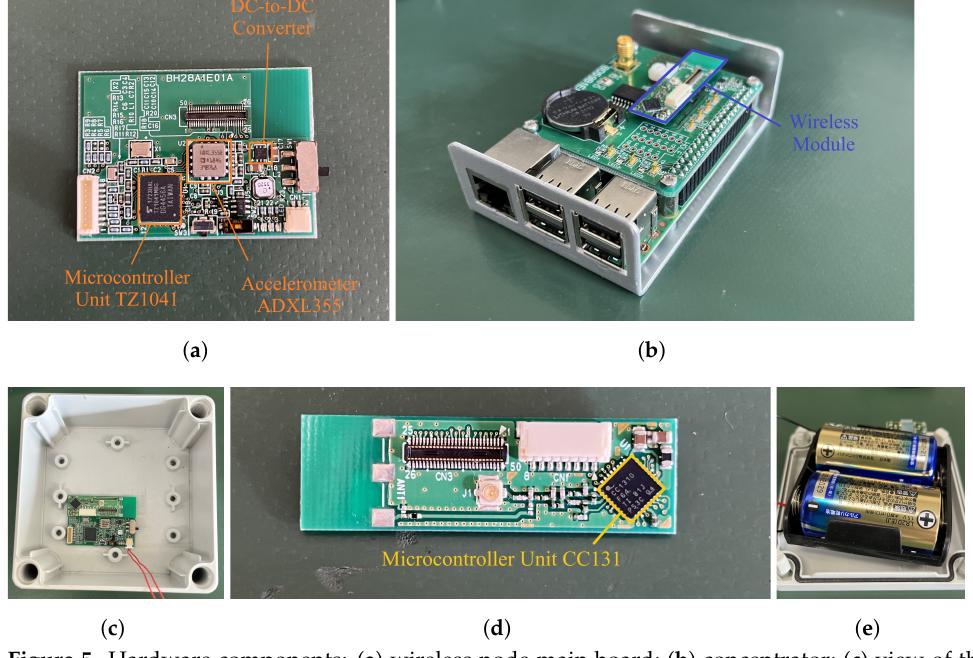
Figure 5. Hardware components: ( a ) wireless node main board; ( b ) concentrator; ( c ) view of the wireless node in the containing case, ( d ) the wireless module and the battery case ( e